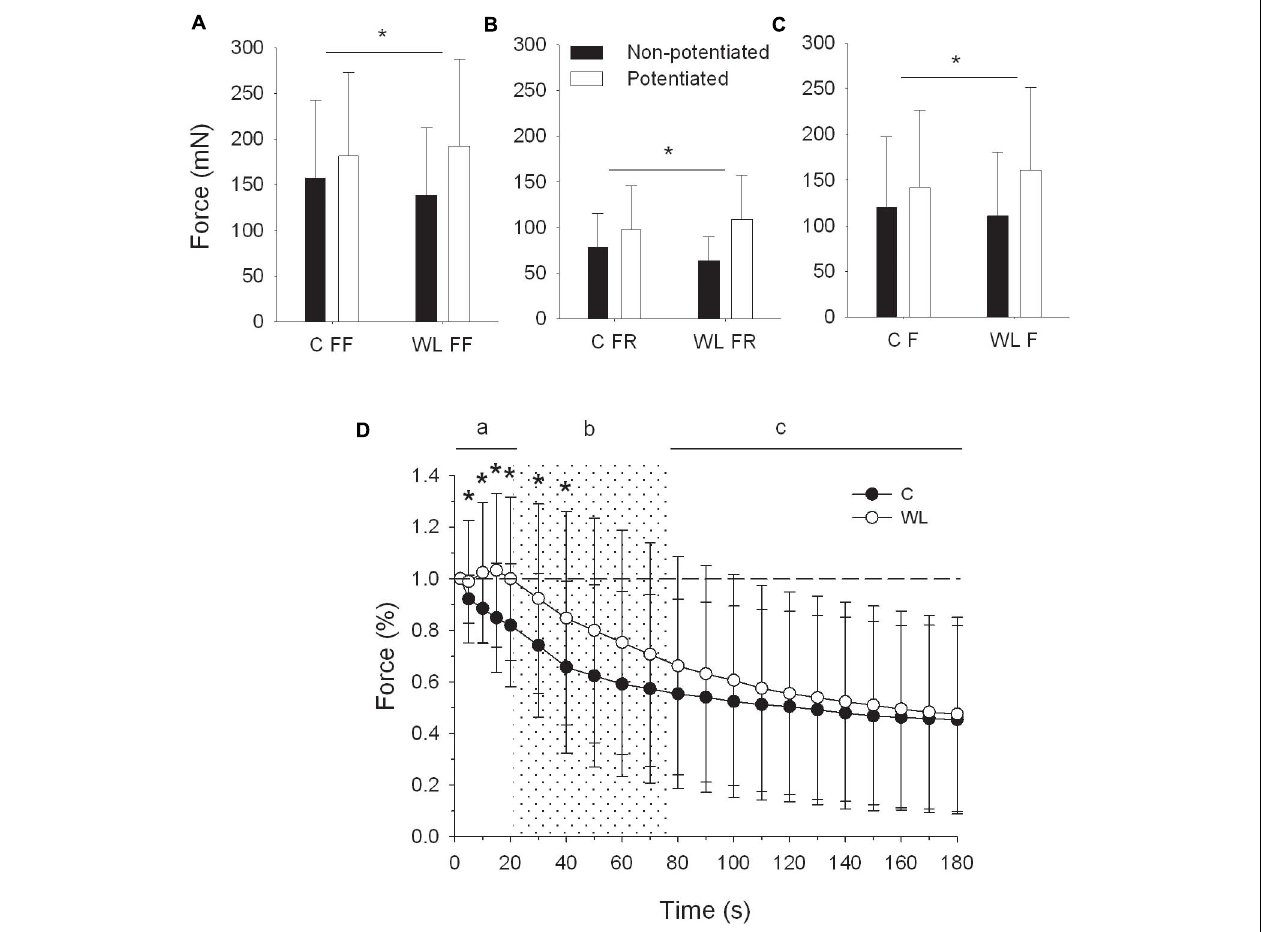
FIGURE 4 | Peak force potentiation of 40 Hz tetanus after resistance training (A–C) , and force profile of 40 Hz tetanus during repeated fatiguing stimulation (D) . (A–C) , * denotes significant differences ( p < 0.05, post hoc comparisons) in force augmentation between trained and untrained rats. (D) , * denotes significant differences ( p < 0.05, post hoc comparisons) between forces of trained and untrained rats for the whole population of fast motor units. Note that force was initially slightly potentiated in trained rats and declined steadily in untrained animals. C, control group; WL, weight lifting group; FR, fast fatigue resistant motor units; FF, fast fatigable motor units; F, whole population of fast motor units.